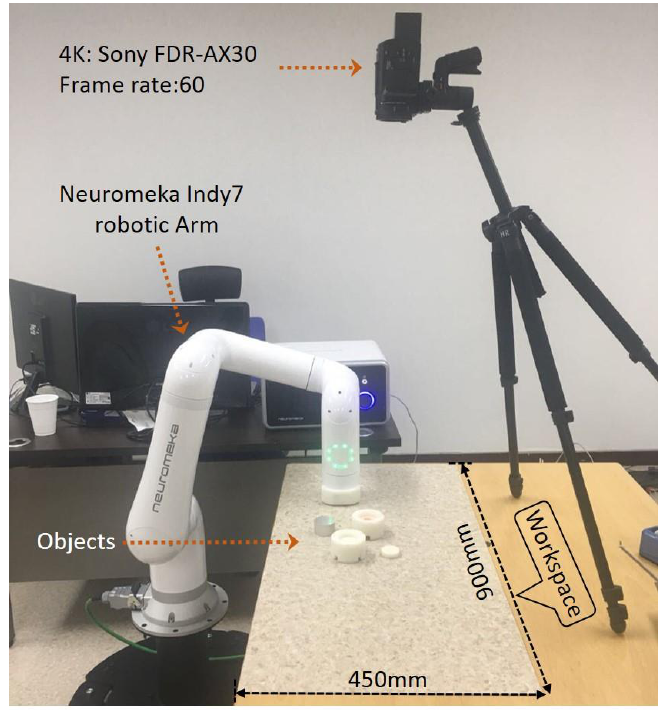
Figure 5. Experimental setup for video collection.